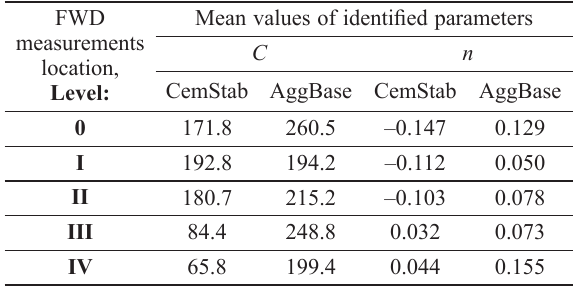
Fig. 9. Ev2 values calculated for assessment the subgrade condition based on values of C and n parameters in a model factoring in stress sensitive layers moduli at different FWD testing Table 3. Mean values of C and n coefficients identified for purposes of plate bearing test simulation for Cement- Stabilised Course and Crushed Aggregate Base Course